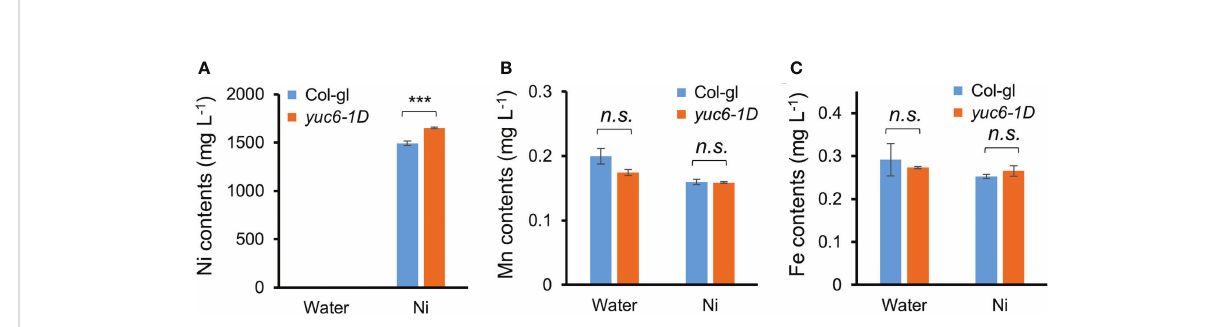
FIGURE 3 Dominant mutant yuc6-1D accumulates higher Ni ions compared to WT. Three-week-old Col-gl WT and yuc6-1D plants were treated with 100 µM Ni for 1 day. Nickel (A) , Manganese (B) , and Iron (C) contents were measured by an ICP-MS. Values are means ± SE of three independent biological replicates. Asterisks indicate signi fi cant differences (*** p < 0.001; n.s. , no signi fi cant) from the WT determined using the two-tailed Student ’ s t -test.